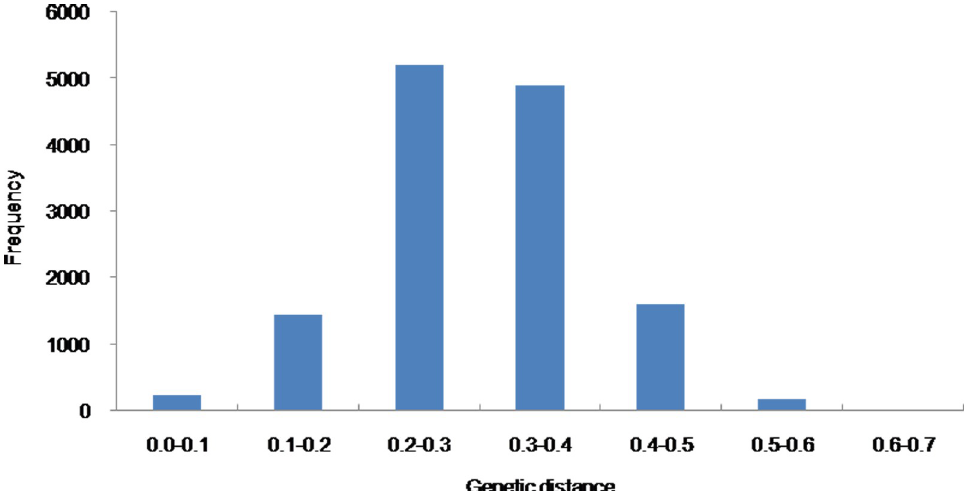
Fig 2. Frequency of pair wise genetic distances in the 165 cauliflower inbred